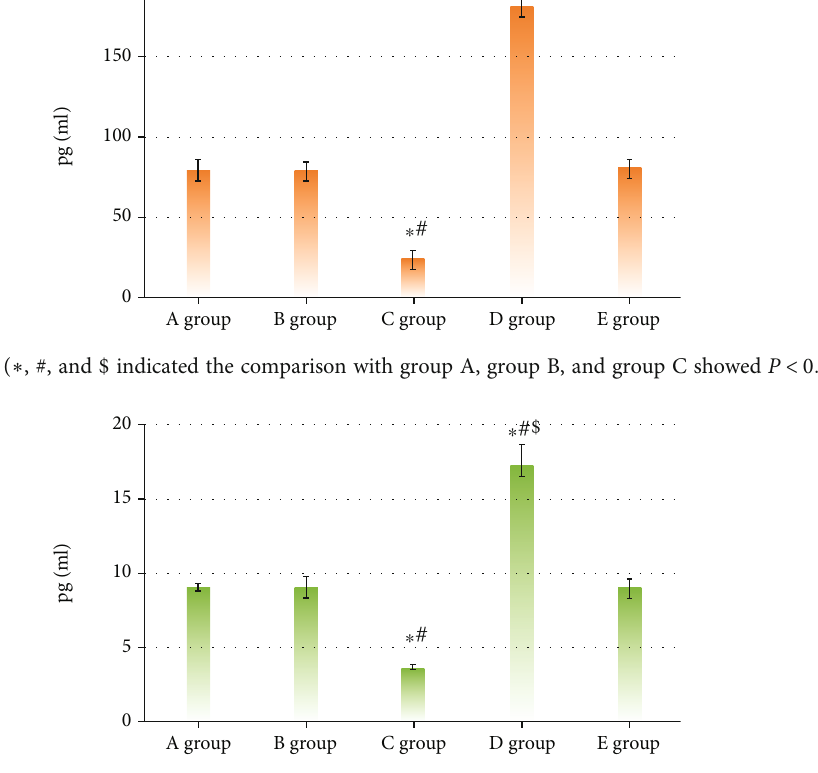
Figure 8: Expression levels of IL-1 β in each group. ( ∗ , #, and $ indicated the comparison with group A, group B, and group C showed P < 0 : 05 ,